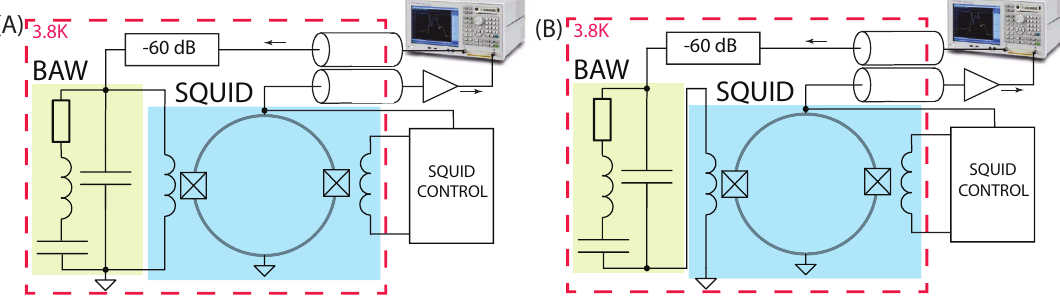
Figure 1. Experimental setups representing two ways to connect a Bulk Acoustic Wave (BAW) resonator and a Superconducting Quantum Interference Device (SQUID) amplifier: ( A ) parallel connection, ( B ) series